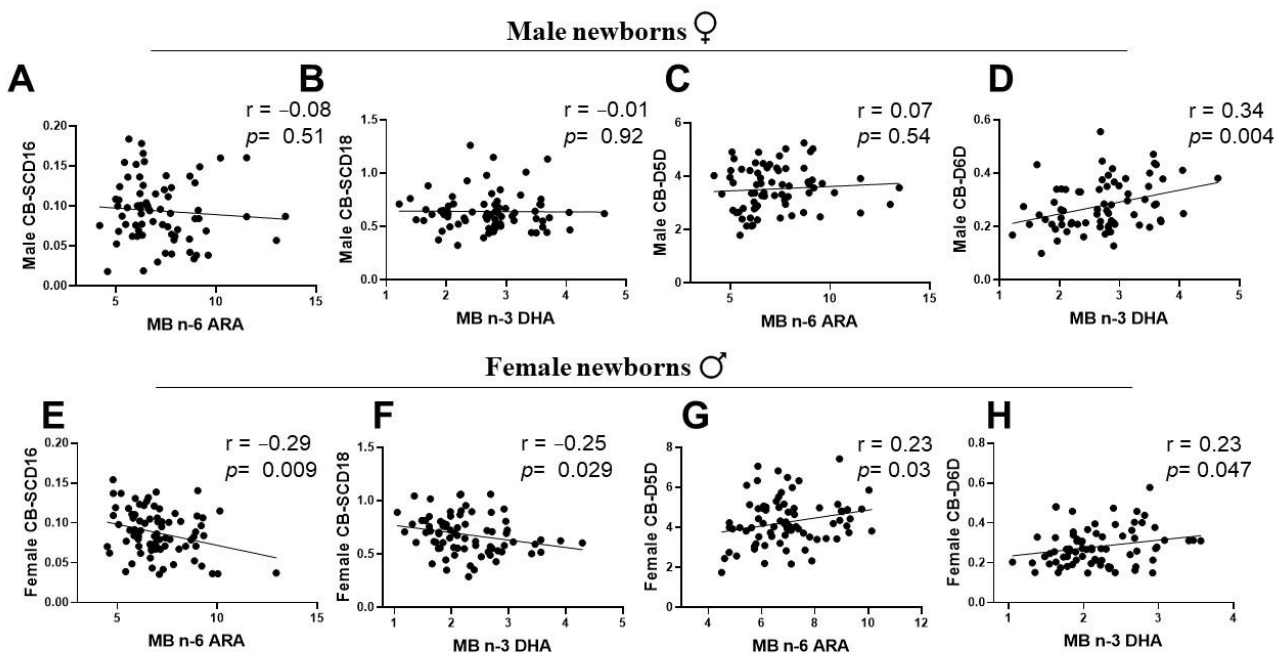
Figure 6. Maternal LC-PUFA negatively correlates with CB-SCD desaturation indices and positively with CB-PUFA desaturation indices (D5D and D6D) in female newborns. ( A – H ) Pearson relationship scatter plots between maternal n-3 and n-6 long chain derivatives of polyunsaturated unsaturated fatty acid (LC-PUFA) and cord blood desaturation indices in the newborn groups: ( A – D ) Males. ( E – H ) Females. Pearson r and p values are shown. LC-PUFA, long chain-polyunsaturated fatty acids; SCD, stearoyl CoA desaturase; D5D, delta-5-desaturase; D6D,